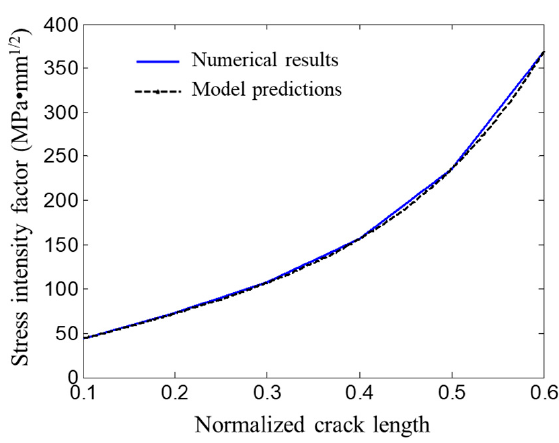
Figure 6. Comparison between numerical results and model predictions under load of 200 MPa.